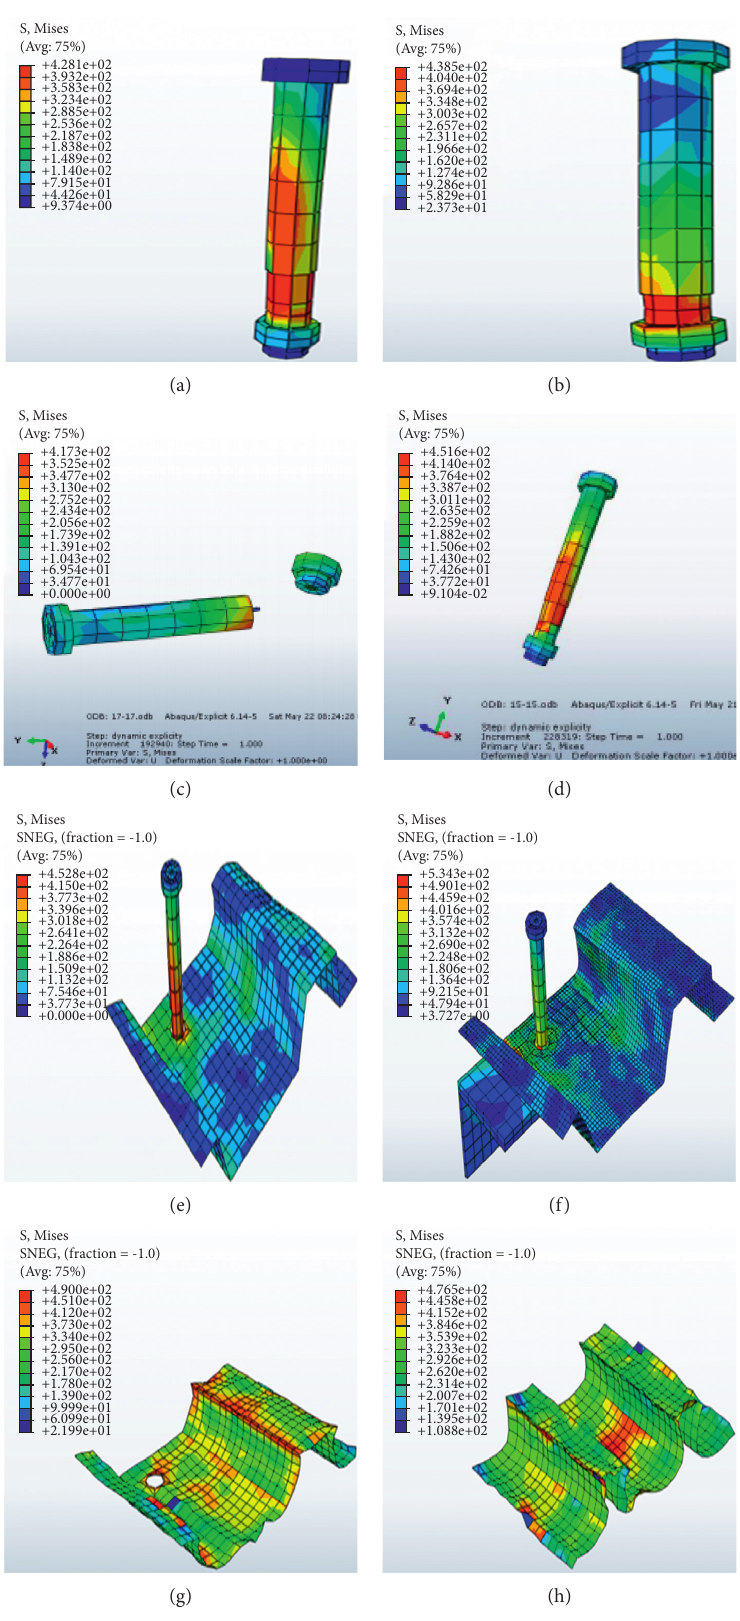
Figure 14: Failure modes of shear connector (a–d) and profiled steel sheeting (e–h) in the